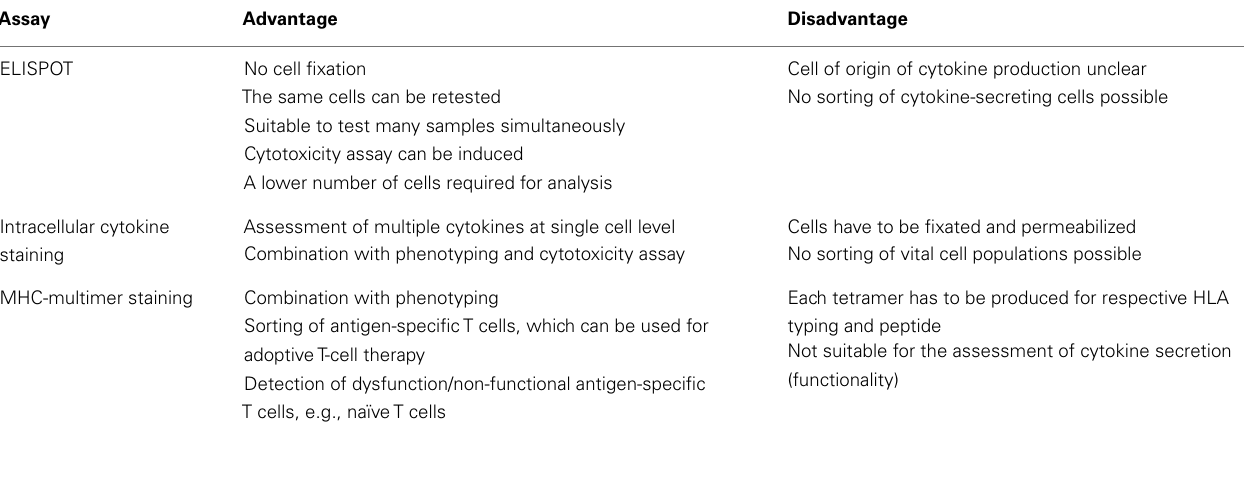
Table 1 | Comparison of threeT-cell